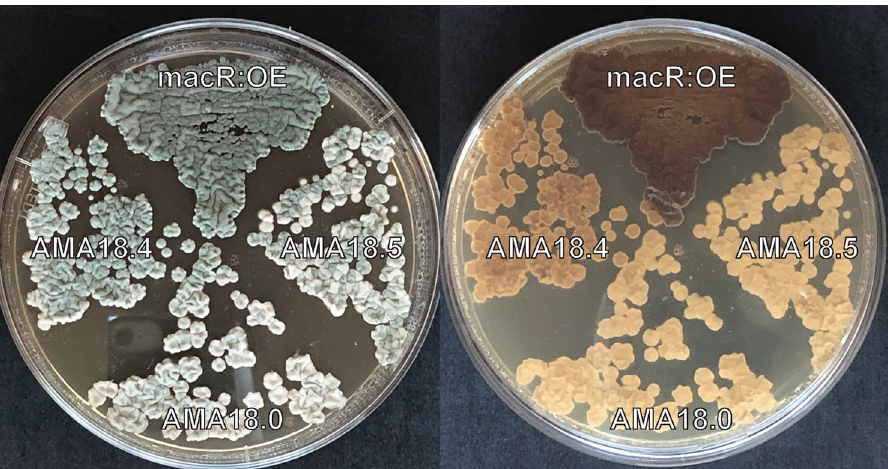
Figure 4. Dark pigmentation of hyphae due to macR overexpression in Penicillium rubens DS68530 macR :OE and in the CRISPRa pAMA18.4 vector carrying strain after 5 days of cultivation on R-agar, compared to AMA18.0 strain carrying pAMA18.0 (no sgRNA) negative